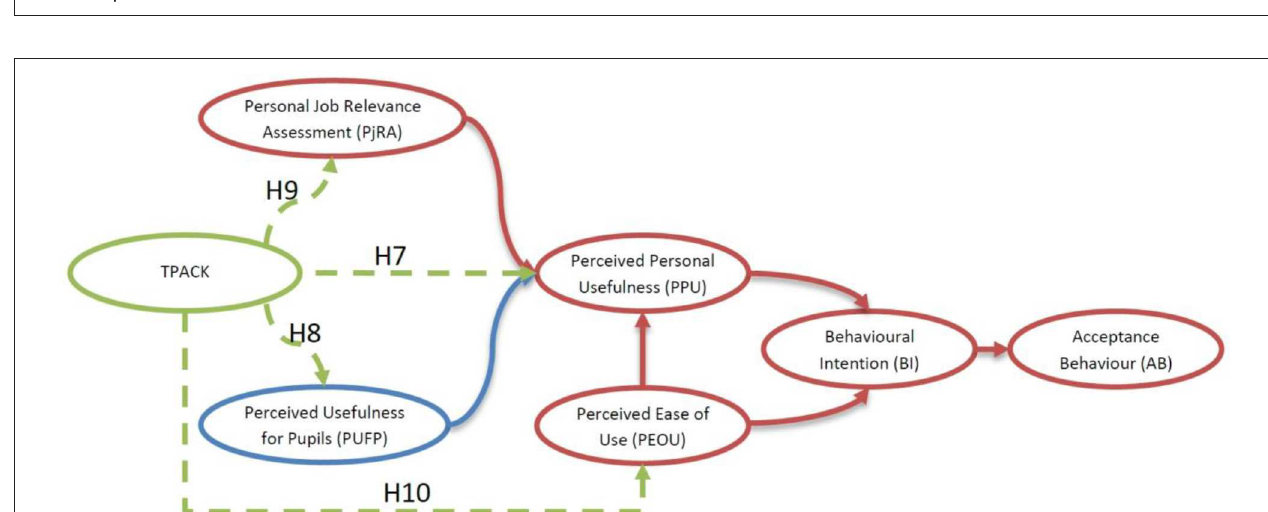
FIGURE 3 | Results of the statistical model calculation.